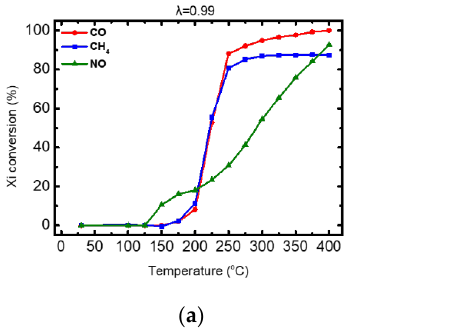
λ = 0.99, ( b ) λ = 1.03. 4 and NO. ( a )